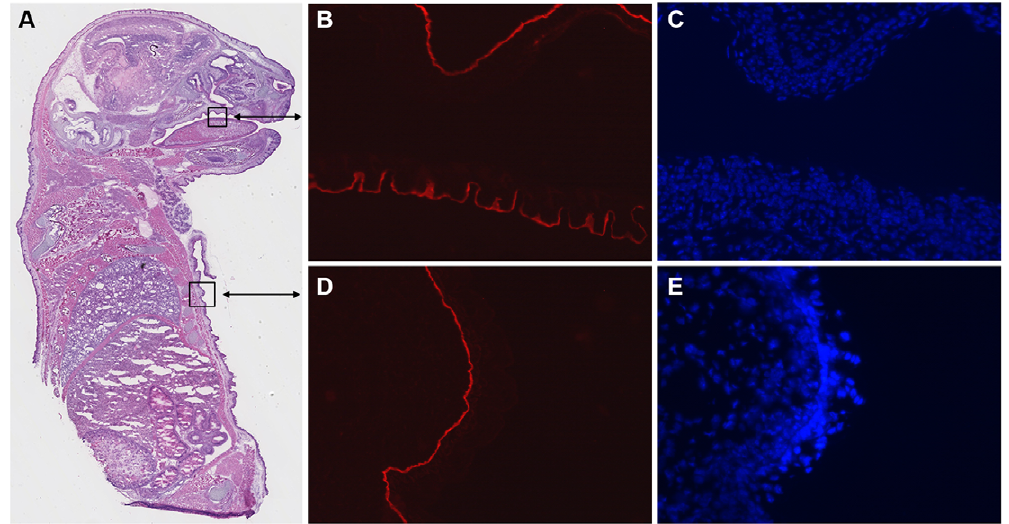
Figure 5. Human laminin c 2 transgene expression is restricted in the rescued Lamc2 KO mice. Whole mount E18 rescued Lamc2 KO embryonic tissue sections were stained with hematoxylin and eosin (H&E) (A) or for human laminin c 2 using an anti-human laminin c 2 antibody followed by TRITC-conjugated antibody (B and D). Slides were mounted with mounting media containing DAPI to allow visualization of nuclei (C and E). Human laminin c 2 was only detected in the mouth (B) and skin (D).